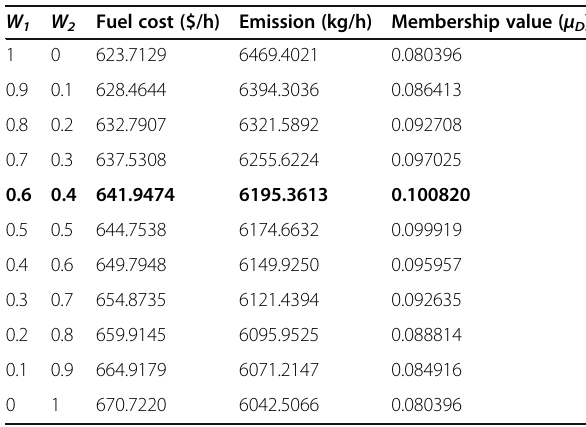
Table 4 Non-dominated solutions for various weighting values acquired by the proposed FSSA